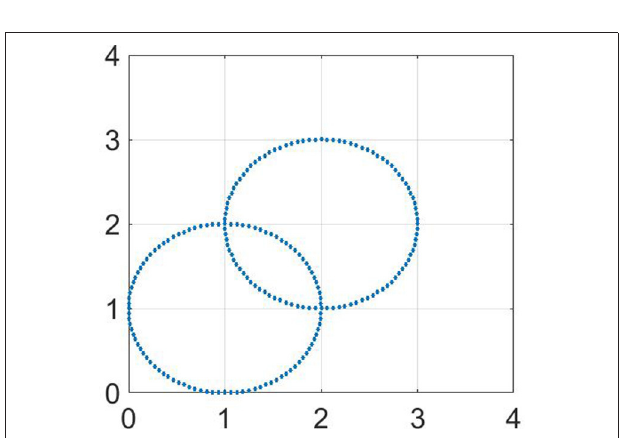
FIGURE 4 | Testing dataset of two intersecting circles.